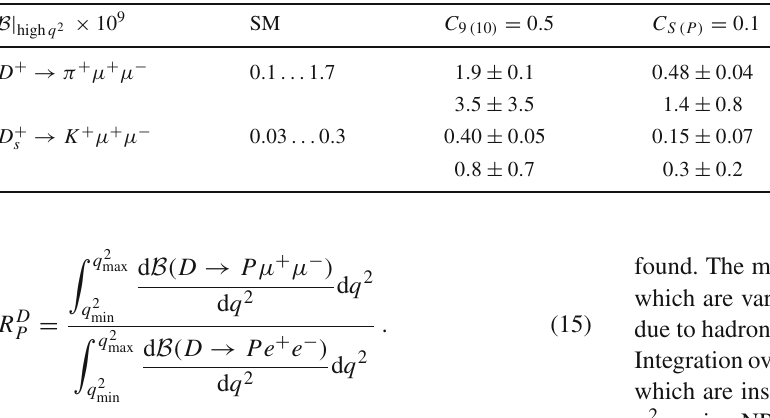
Fig. 3 The differential branching fractions in the SM and in three BSM scenarios in the high q 2 –region for D + → π + μ + μ − (plots to the left) and D + s → K + μ + μ − (plots to the right). Orange bands correspond to the pure resonant contributions. The band width represents theoretical uncertainties, where we distinguish between pure BSM contributions (upper plots) and BSM benchmarks including interference with the SM resonance contributions, such that the variation of the strong phases also effects the BSM predictions (lower plots). Predictions for BSM coefficients C ( (cid:3) ) are similar to those of C 7 (cf. Eq. (12)), and not shown